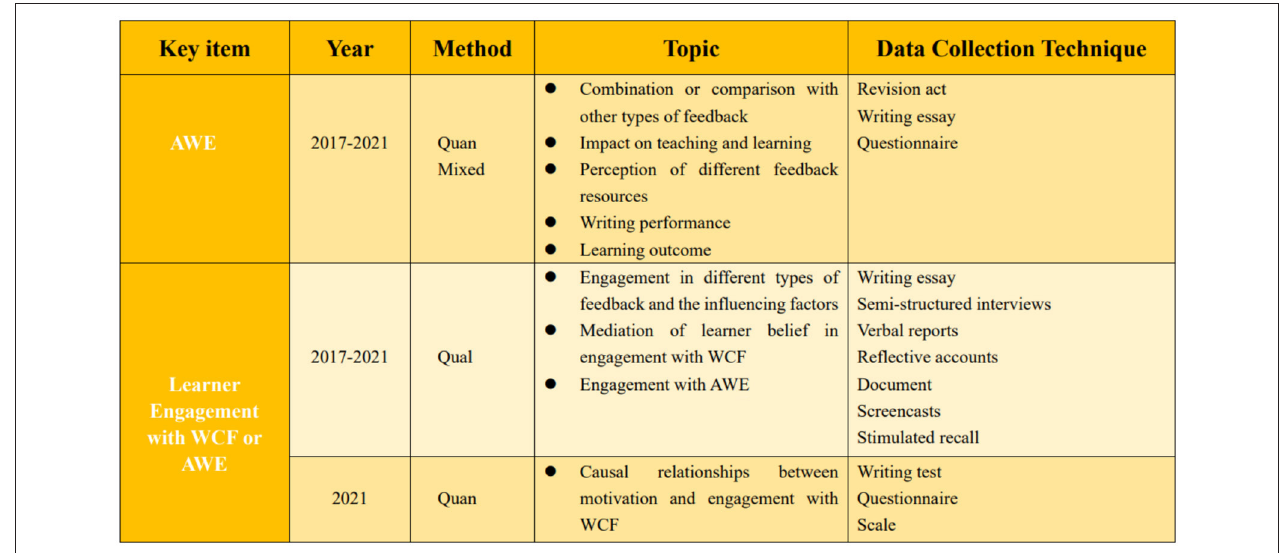
FIGURE 2 | Inclusion of the empirical studies in this